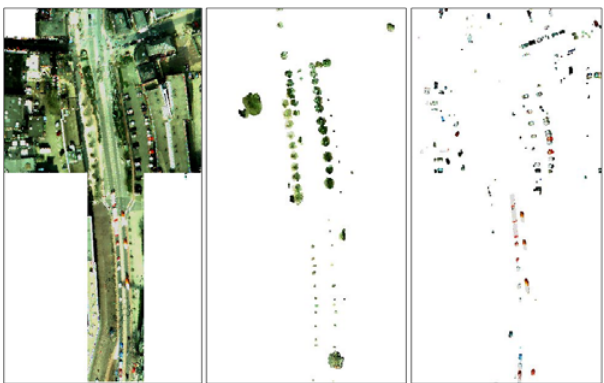
Figure 7: Classification maps of dataset Enschede with image (left), trees (middle) and vehicles (right).